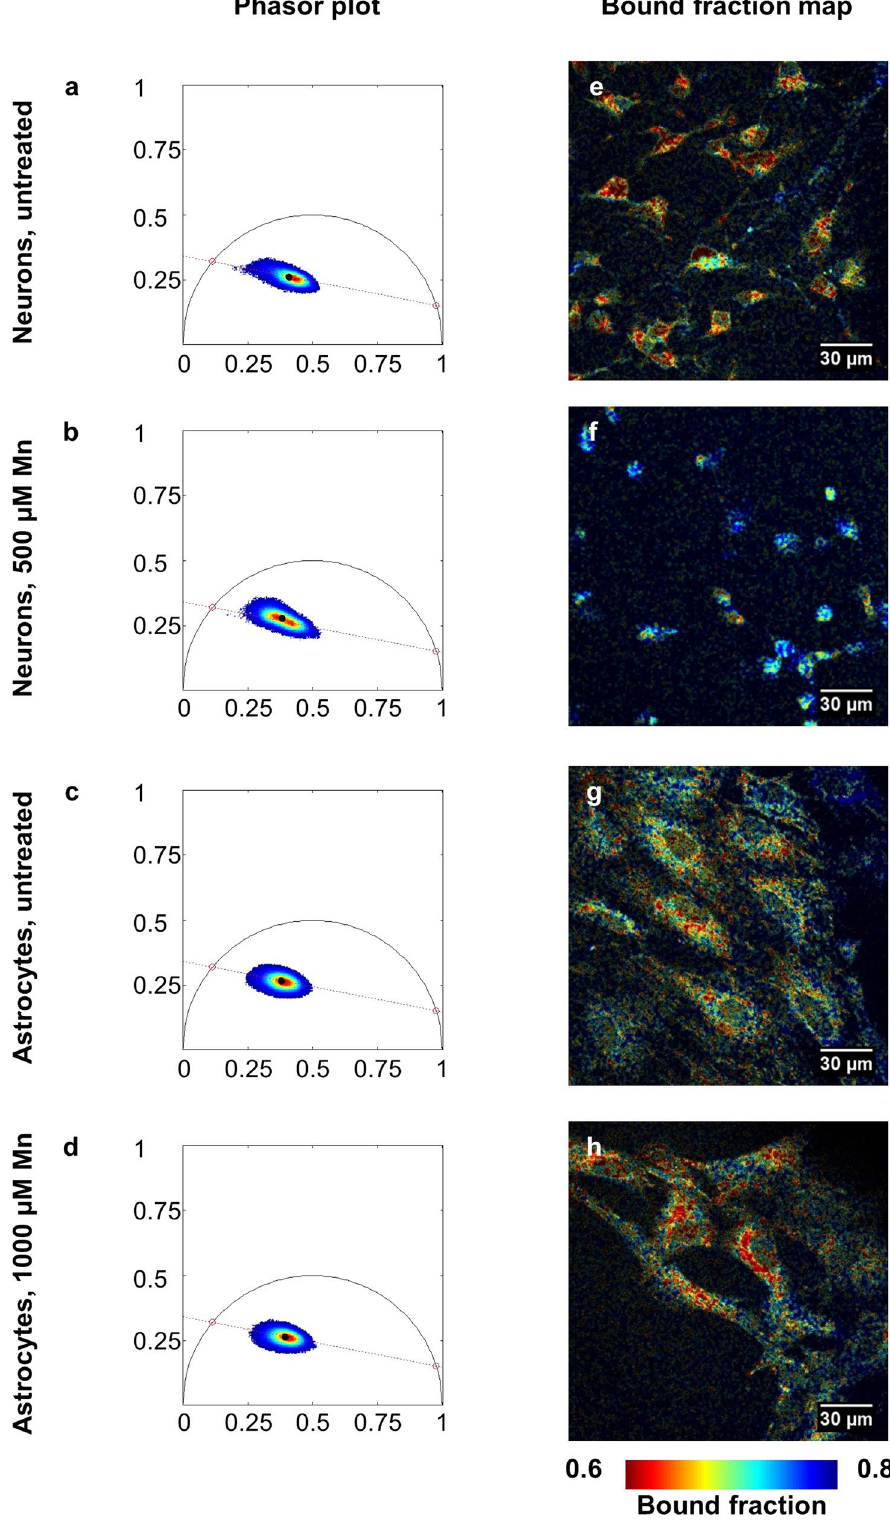
Figure 8. Phasor analysis of NAD(P)H fluorescence lifetime. ( a–d ) Phasor plots of neurons and astrocytes with and without Mn plotted along a standard curve intersecting 5.5 ns and 0.31 ns. ( a , b ) Neurons treated with Mn ( b ) have a phasor distribution shifted towards bound NAD(P)H relative to the control ( a ). ( c,d ) Astrocytes treated with Mn ( d ) have a phasor distribution shifted towards free NAD(P)H relative to the control ( c ). ( e–h ) These shifts are echoed in bound fraction maps formed from a representative image from each